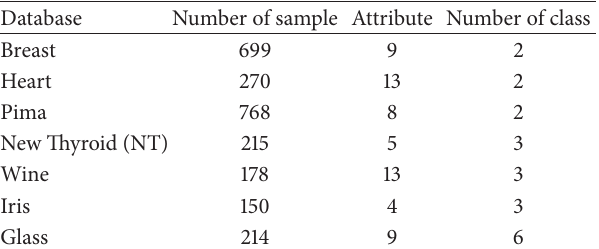
Table 3: Database information for comparative